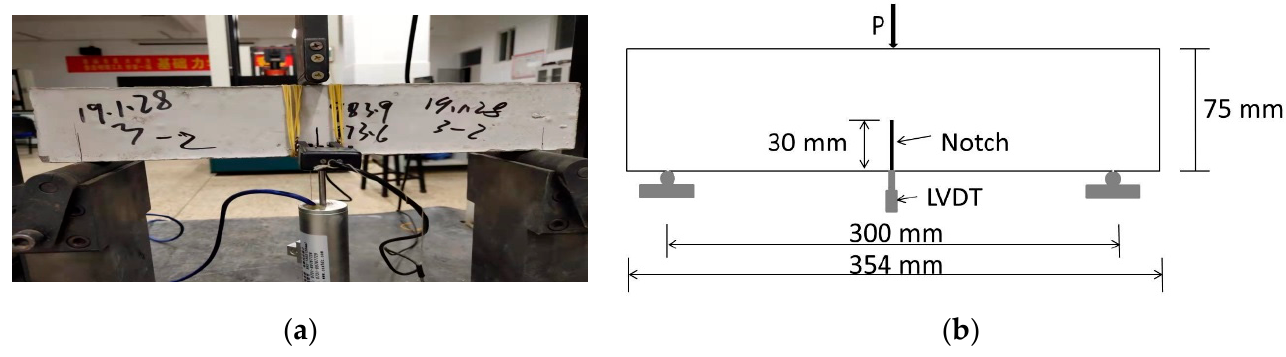
Figure 5. Fracture toughness test device. ( a ) Photo of the test device; ( b ) diagram of the test device. Test method of fiber-bridging complementary energy. Via the method of [23,31], the fiber-bridging complementary energy was obtained using a single-crack tensile test. The dimensions of the sample are shown in Figure 6a. Before the test, an opening was pre-cut into the middle of the specimen (as shown in Figure 6a), the width of which was 0.5 mm. The test was carried out on a universal testing machine at a loading rate of 0.5 mm/min. During the test, two LVDTs were arranged near the opening to record its width, as shown in Figure